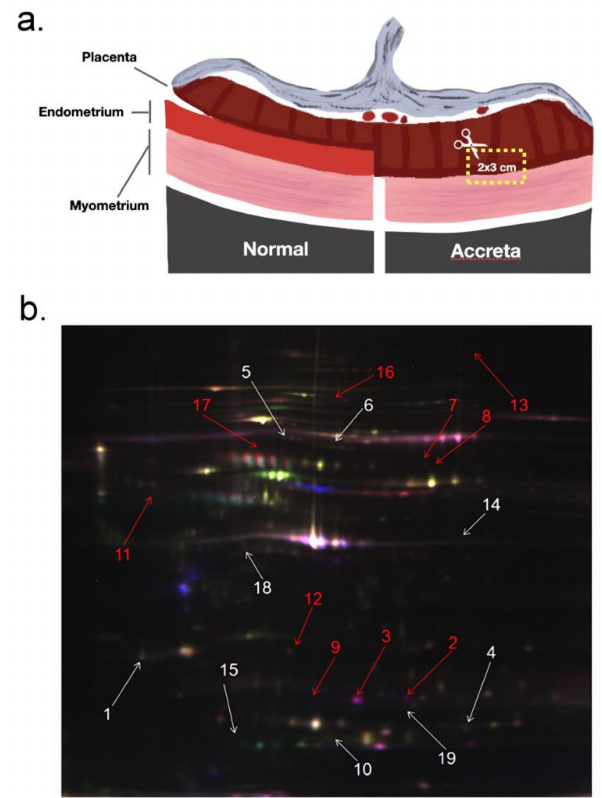
Figure 1. The illustration of the collected tissue sample from placenta trophoblast villous and the example of one 2D-DIGE assay on the collected placental tissue sample. ( a ) For the placenta tissues of PAS subjects, the trophoblast villous invading into the uterine muscle layer was